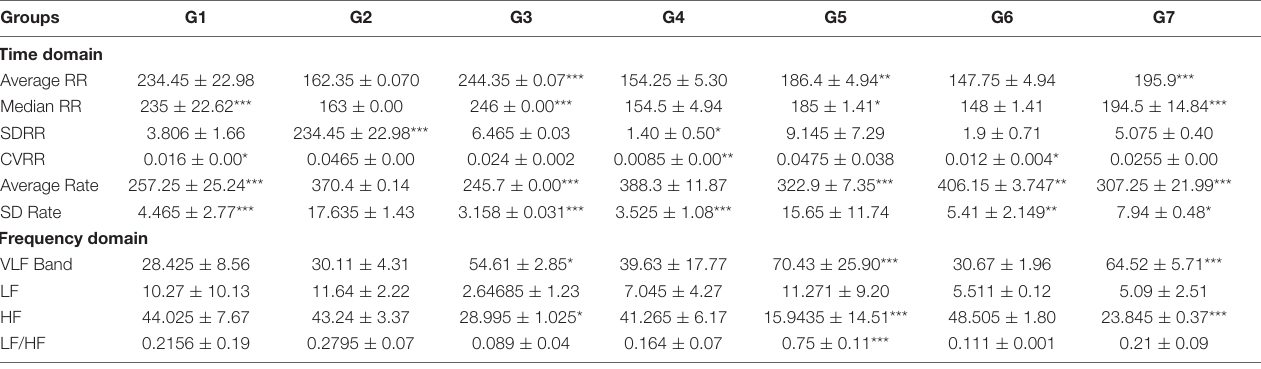
TABLE 1 | Effect of VOA and VIN on HRV of experimental animals.